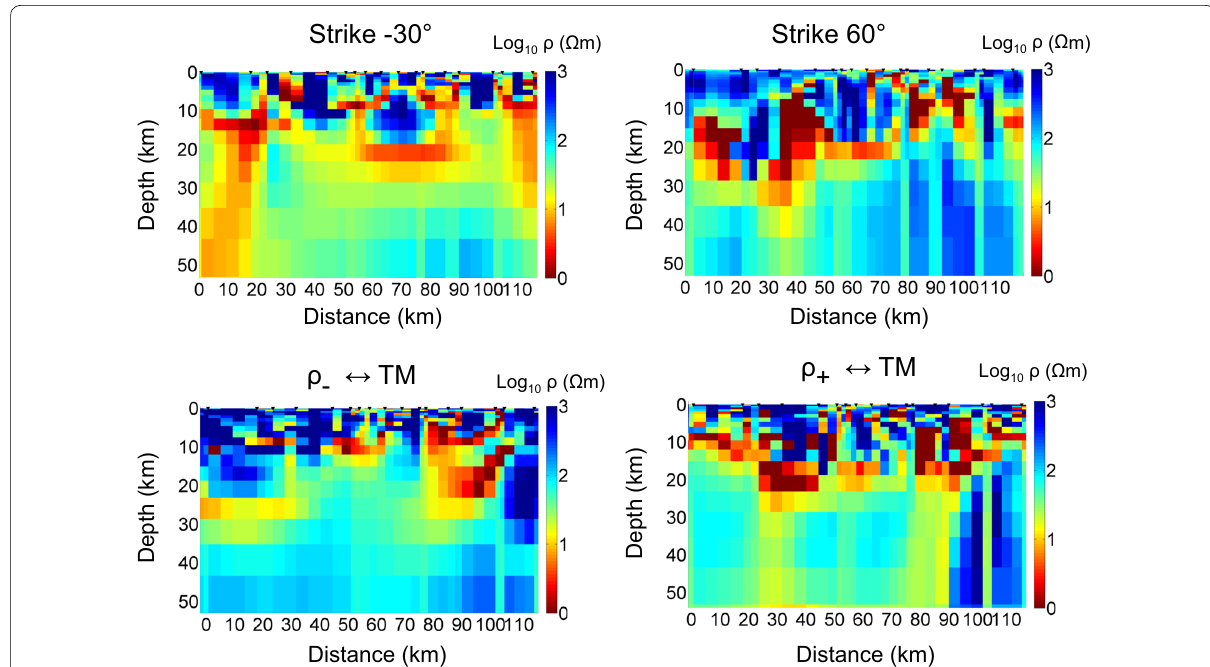
Fig. 8 The roughest models obtained by inverting the amplitude of the TM mode and the phases of both modes. The computed TE apparent resistivities of these models are compared with the corresponding data pseudo‑sections in the last four figures